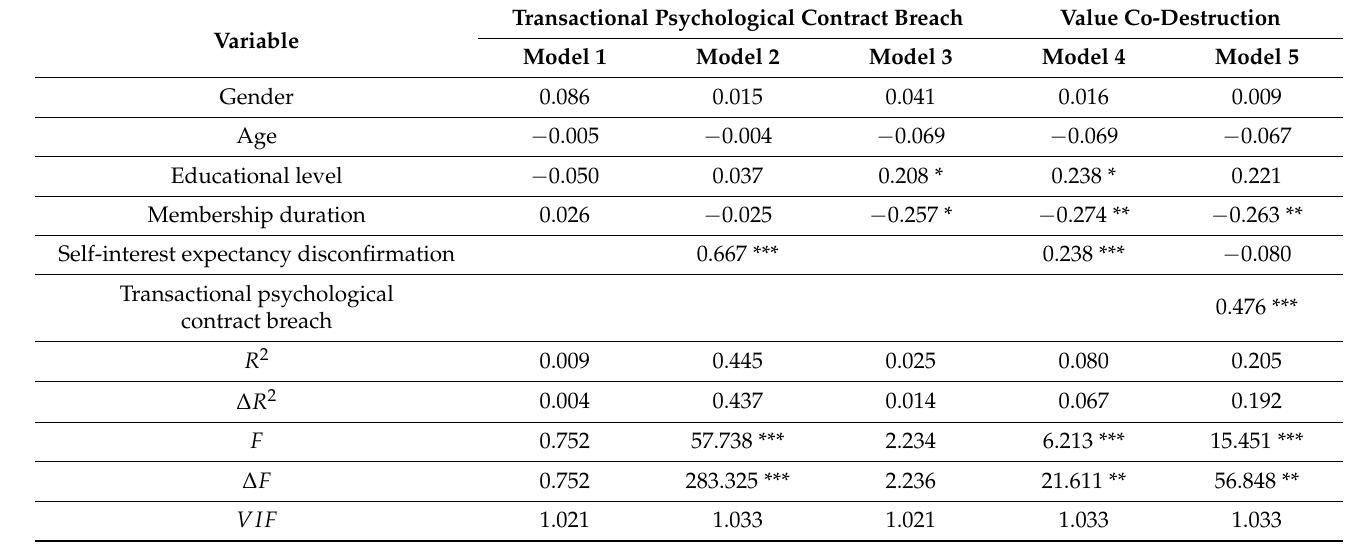
Table 6. Direct effect of self-interest expectancy disconfirmation and mediating effect of transactional psychological contract breach on value